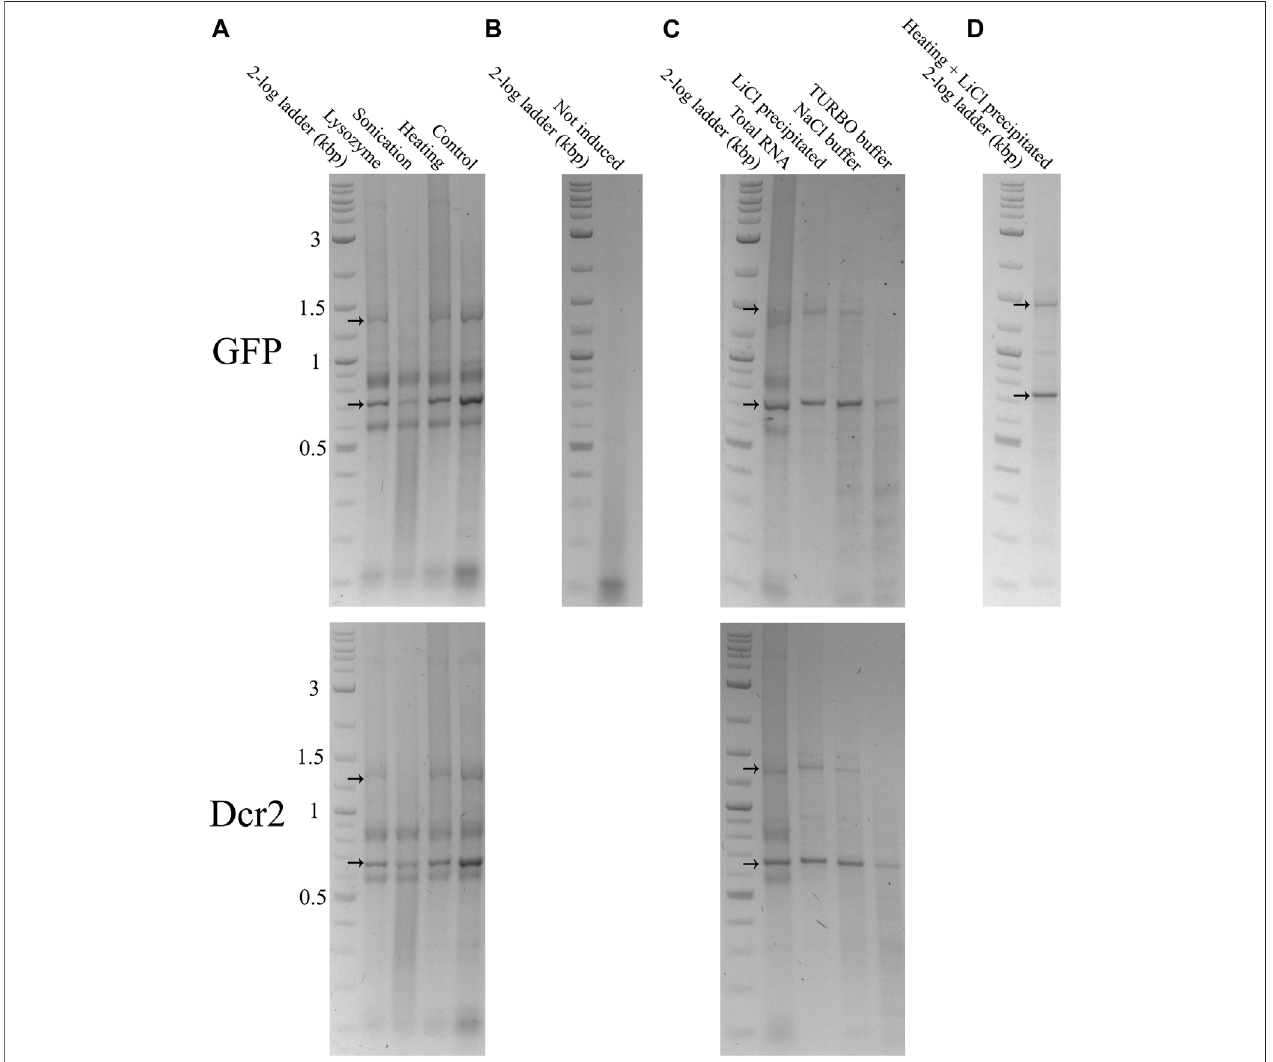
FIGURE 2 | Total and puri fi ed RNA extracted from HT115 (DE3) bacteria transformed with a L4440- GFP (upper gels) or L4440- Ha Dcr2 (lower gels) expression construct was loaded into 1% agarose gels in TAE buffer. The RNA was separated by size through electrophoresis at 120V for 2 h. The nucleic acids were imaged with the GelRed ® (Biotium) stain under UV light. Arrows indicate the dsGFP and dsDcr2 bands at the ~700 bp and ~650 bp positions of the DNA ladder and the persistent secondary structure dsRNA band at ~1,400 bp and ~1,300 bp respectively. (A) : 400 ng total RNA extracted from induced bacteria treated with a control protocol or three pre-treatments. (B) : 400 ng total RNA extracted using the heating pre-treatment from non-induced bacteria. (C) : Comparison between 400 ng total RNA extracted from induced bacteria with the heating pre-treatment and dsRNA puri fi ed from 400 ng total RNA through three puri fi cation methods. The band intensities indicate the ef fi ciency of the applied dsRNA puri fi cation protocols. Thus, the “ Heating ” lane in panel A is equal to the “ Total RNA ” lane in panel (C) . (D) : 92 ng dsRNA puri fi ed from 400 ml of induced bacterial culture using the heating pre-treatment and LiCl